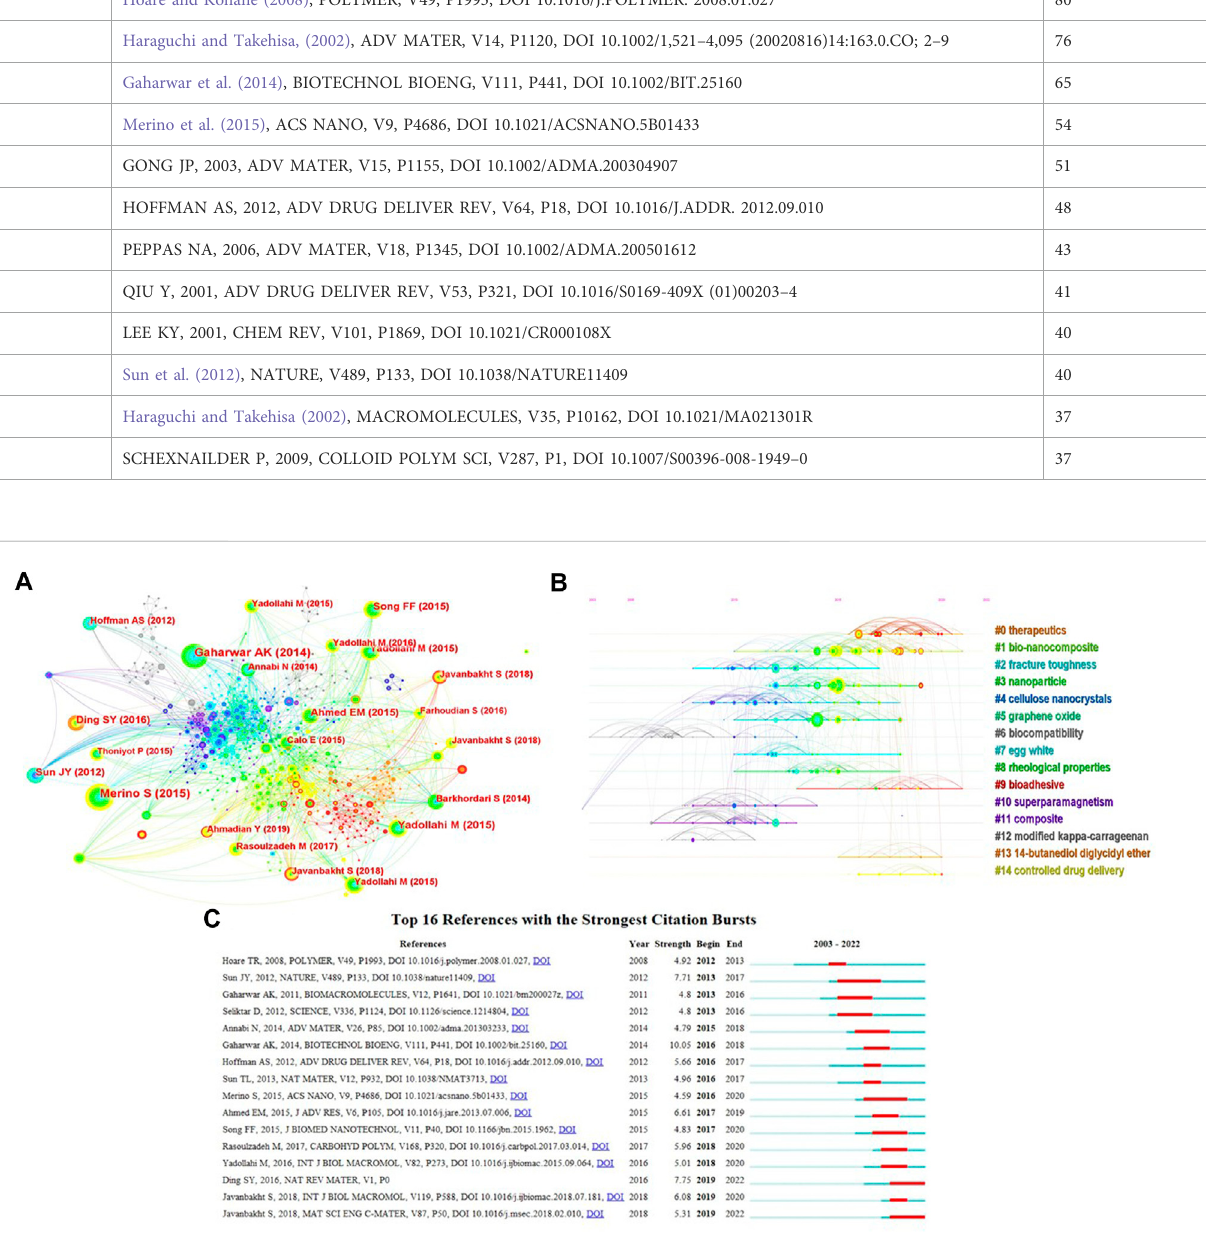
Frontiers in Bioengineering and